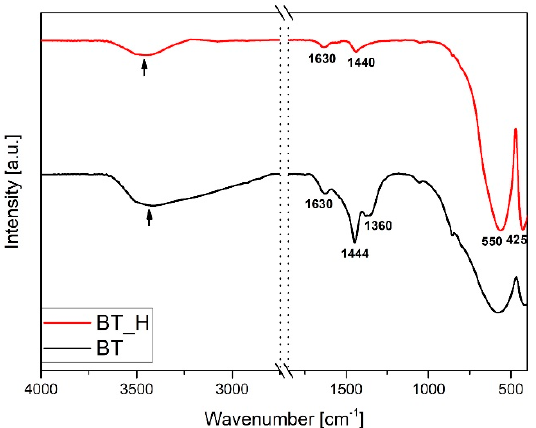
Figure 2. FTIR spectra of powders produced by sol − gel method at ambient pressure (BT) and hydrothermal conditions (BT_H).